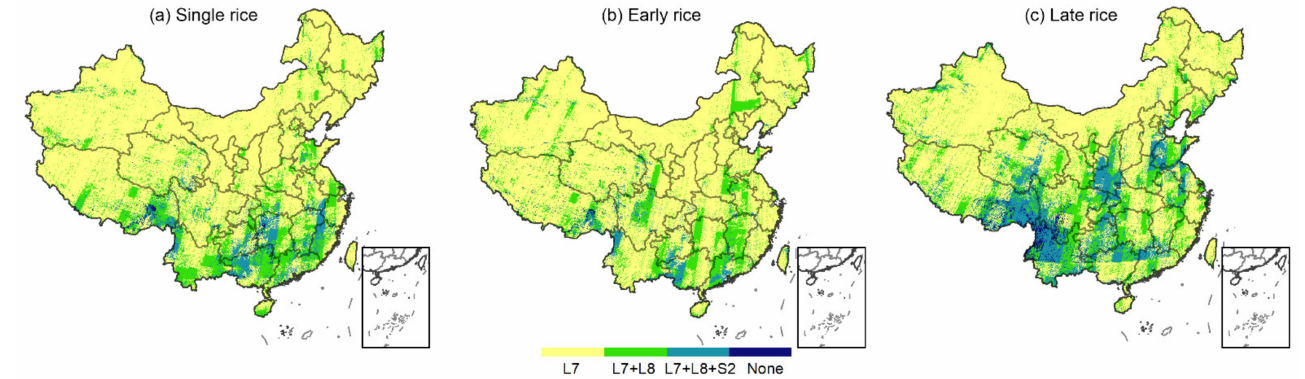
Figure 8. Spatial patterns of different sensors and their combinations for meeting the requirements of remote sensed identification of ( a ) single rice, ( b ) early rice, and ( c ) late